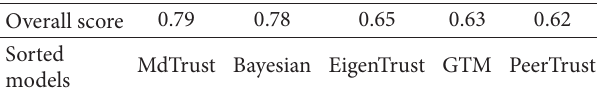
Table 2: Sorted results of evaluated trust models. Overall score Sorted